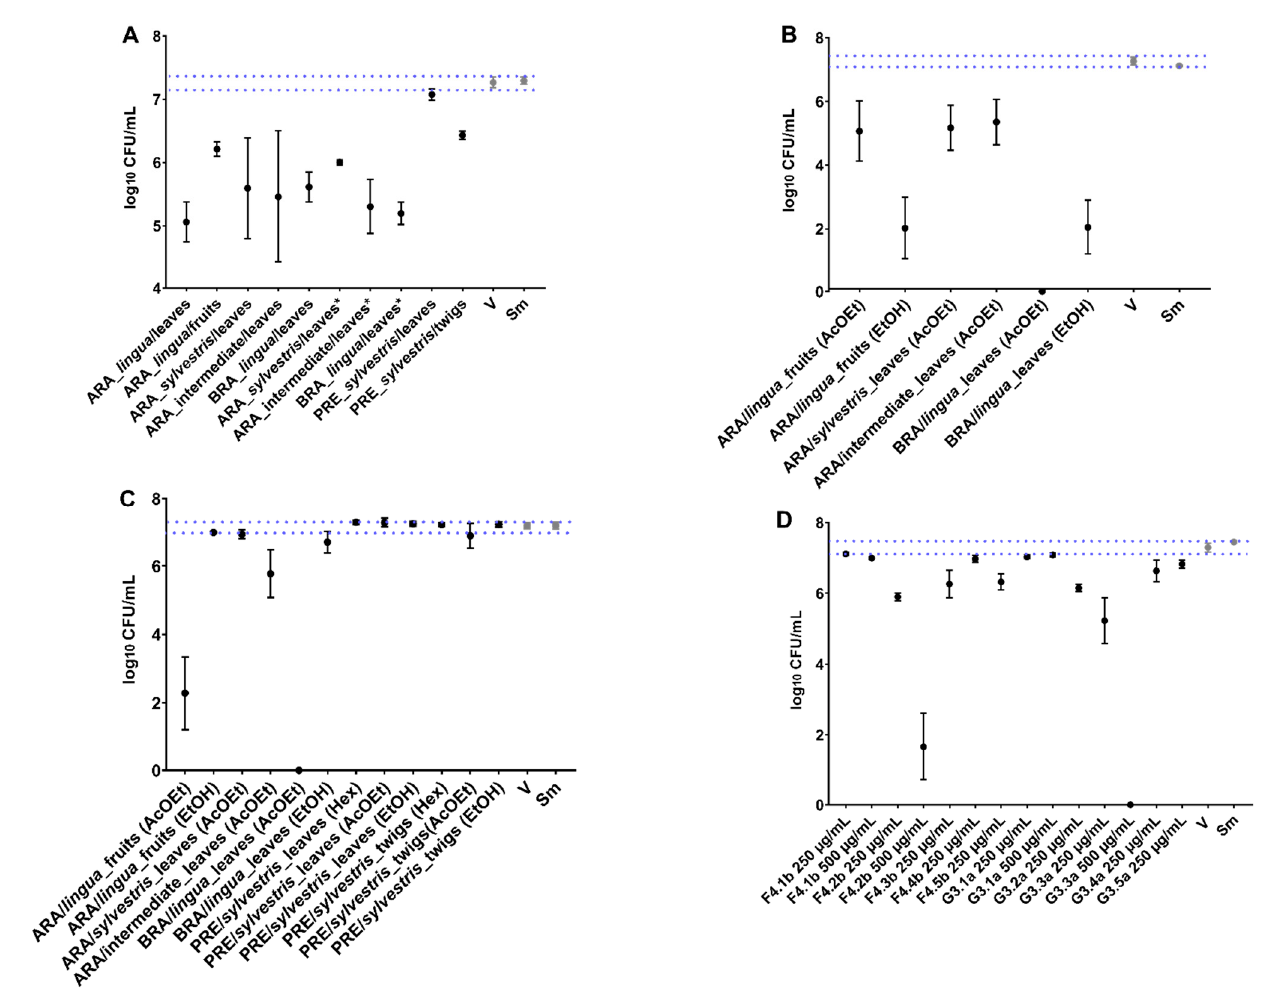
Figure 2. The activity of crude extracts, fractions, and molecules of C. sylvestris against initial biofilms. The graphs show in ( A ) log 10 CFU of the early (24 h) biofilms treated by the crude extracts (500 µg/mL); ( B ) log 10 CFU of the early (24 h) biofilms treated by fractions obtained via methodology 1 (dry fractions in sample concentrator, 250 µg/mL); ( C ) log 10 CFU of biofilms treated by fractions obtained via methodology 2 (dry fractions in the fume hood, 250 µg/mL); ( D ) log 10 CFU of the early (24 h) biofilms treated by SPE-C18 fractions of PRE/SP (250 µg/mL and 500 µg/mL). The central data are the mean, and the error bars are the confidence interval (95%CI). The dotted lines use vehicle data to compare the effectiveness of tested treatments. The growth control (no treatment) is represented as Sm for S. mutans and V for the vehicle control (with the concentration in each well being 1.75% EtOH and 0.31% DMSO for the crude extracts, while for the AcOEt, EtOH, and Hex fractions, it was 5.26% EtOH and 0.94% DMSO, finally for the SPE-C18 fractions, 2.63% EtOH). In ( A ), the asterisk indicates the raw extracts with the pH adjusted to the value close to that of the vehicle. The experiments were performed in triplicate on two separate occasions ( n = 2).